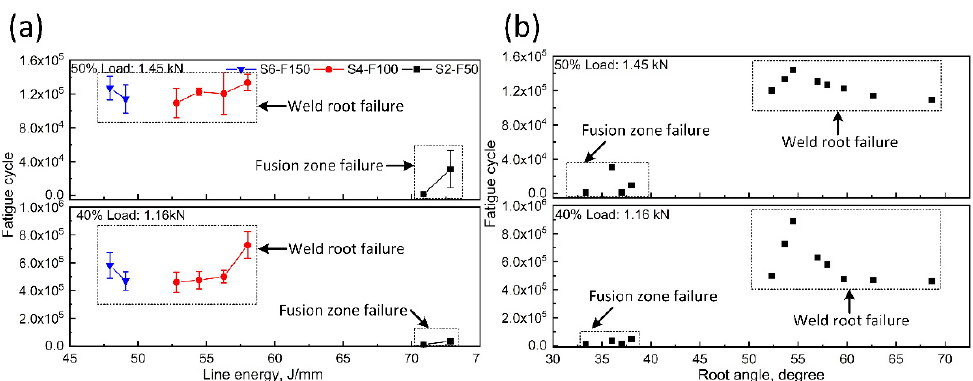
Figure 14. ( a ) Distribution of fatigue failure cycles at 50% load (1.45 kN—top chart) and 40% load (1.16 kN—bottom chart) as a function of welding parameters, grouped with two types of failure mode and ( b ) relationship between the fatigue failure cycles and weld root angle, showing the significantly improved fatigue performance in the weld root failure mode, with the maximum fatigue cycle at the root angle about 55 ° .